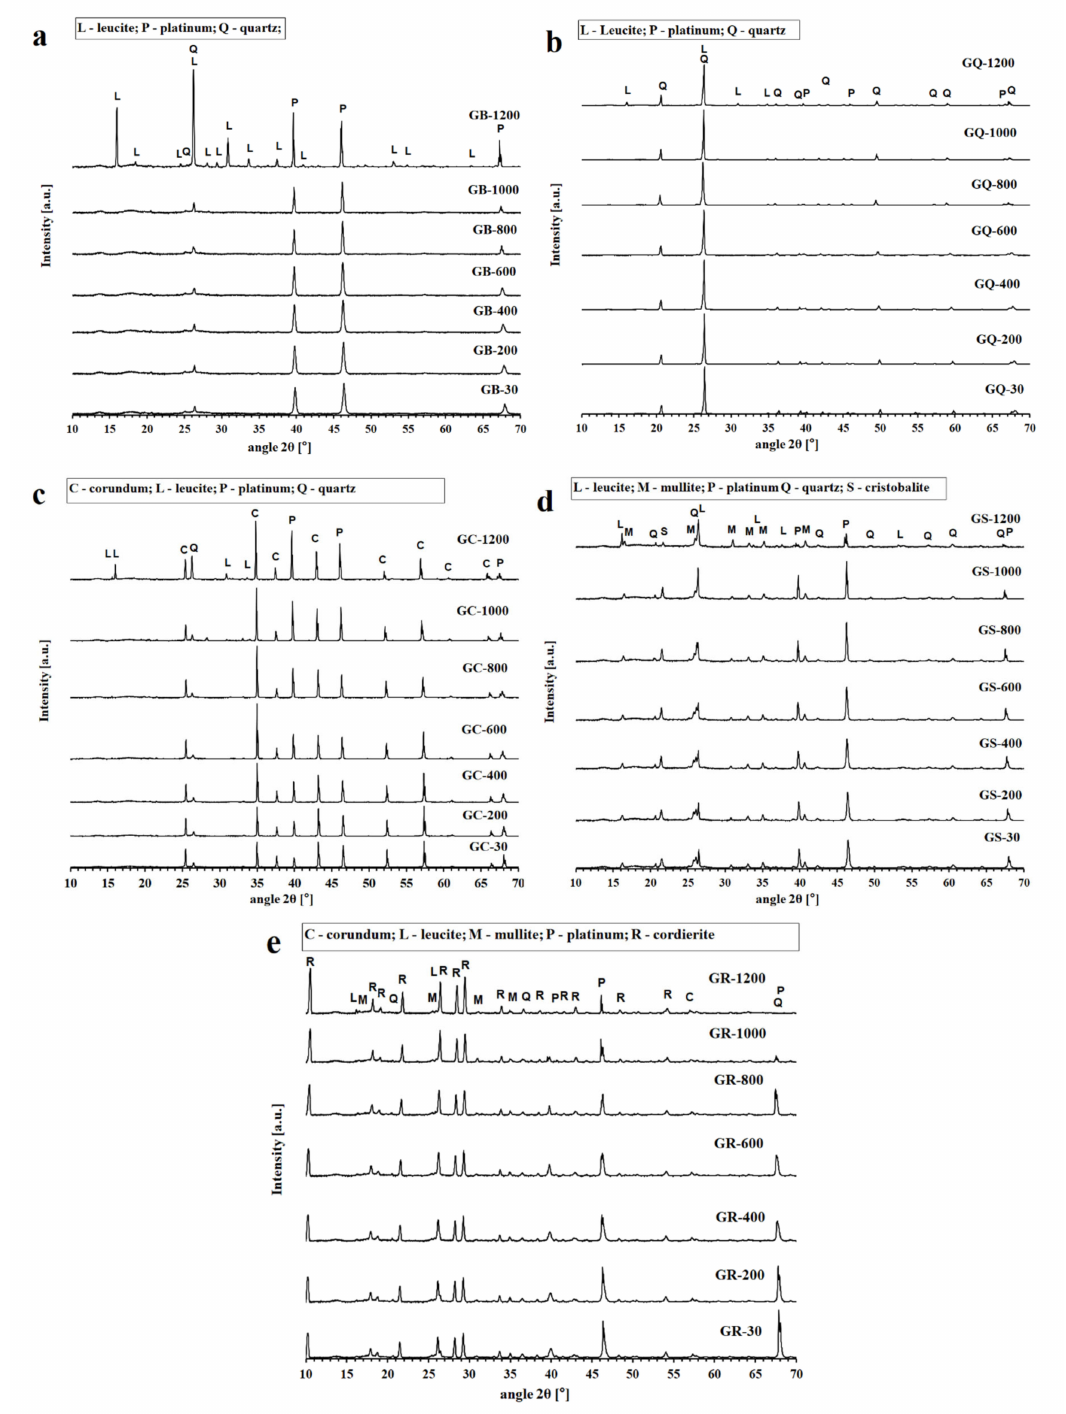
Figure 2. XRD patterns of geopolymer binder ( a ) and geopolymer composites ( b —quartz, c —corundum, d —chamotte, e —cordierite) tested in situ at temperatures from 30 ◦ C to 1200 ◦